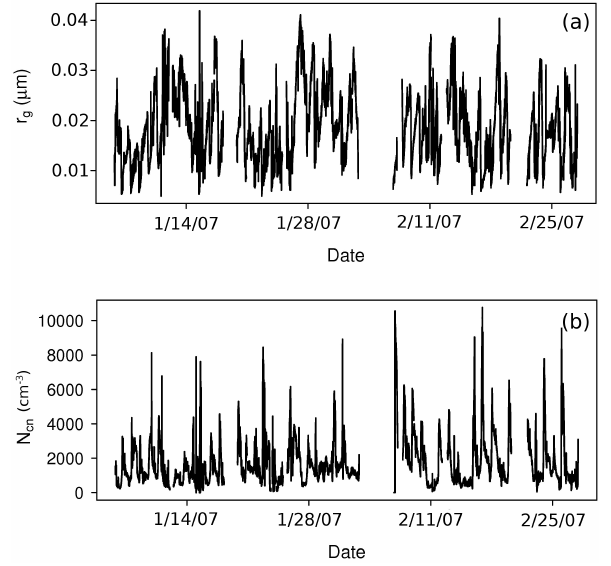
Fig. 4. Time series of (a) r g and (b) N cn estimated from observa- tions collected during the ISPA campaign at SPL in 2007. Note that r g is estimated by fitting a single lognormal mode to the aerosol size distribution data. N cn was derived from the sum of all aerosol observed by the SMPS and